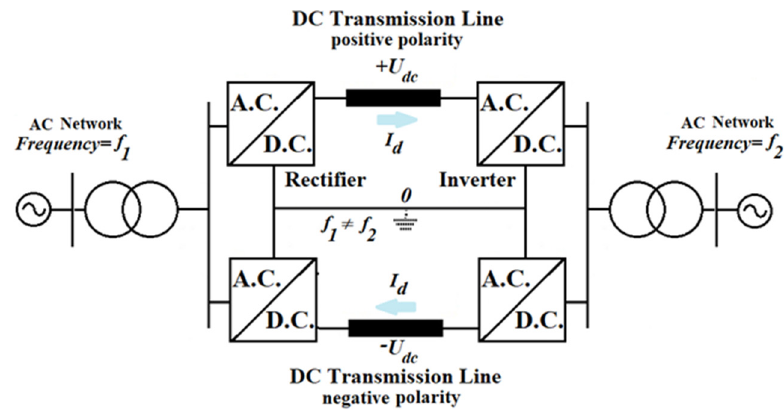
Figure 6. HVDC back-to-back links.